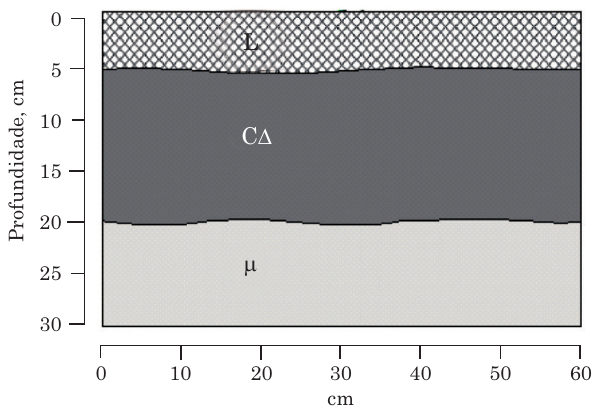
Figura 1. Perfil cultural do Latossolo Vermelho distrófico húmico, antes da instalação do ensaio: L é a camada de solo solto com macro e microagregados, porosidade visível a olho nu e abundante presença de raízes; C ∆∆∆∆∆ , a camada de solo com estrutura maciça e homogênea, sem porosidade visível a olho nu e menor presença de raízes em relação à camada L; e µµµµµ , a camada de solo com estrutura na forma de grânulos e de blocos, típica de Latossolo